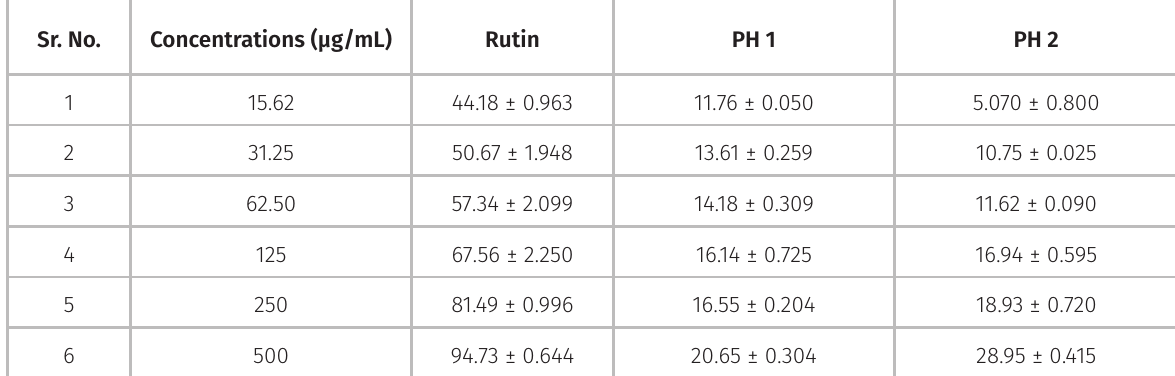
Table I. The percentage DPPH scavenging activities of samples and rutin at different concentrations. Sr.